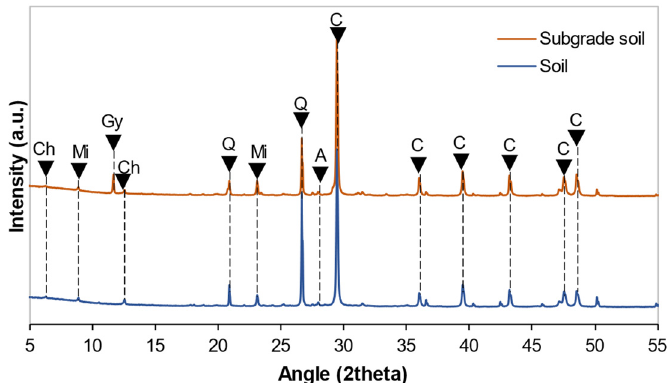
Figure 5. Diffractograms of soil and subgrade soil. Gy: gypsum, A: albite, Ch: chamosite, Q: quartz, Mi: mica, C: calcite.